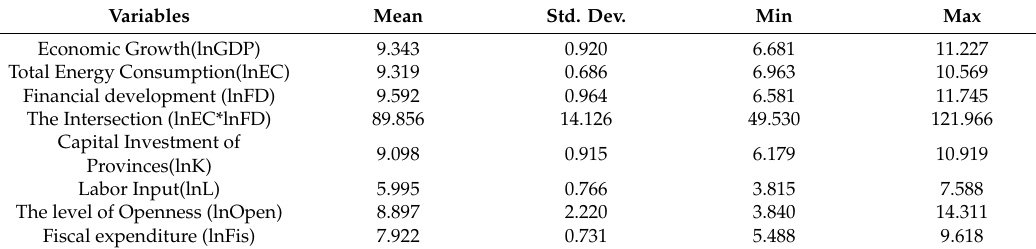
Table A2. Statistical description of